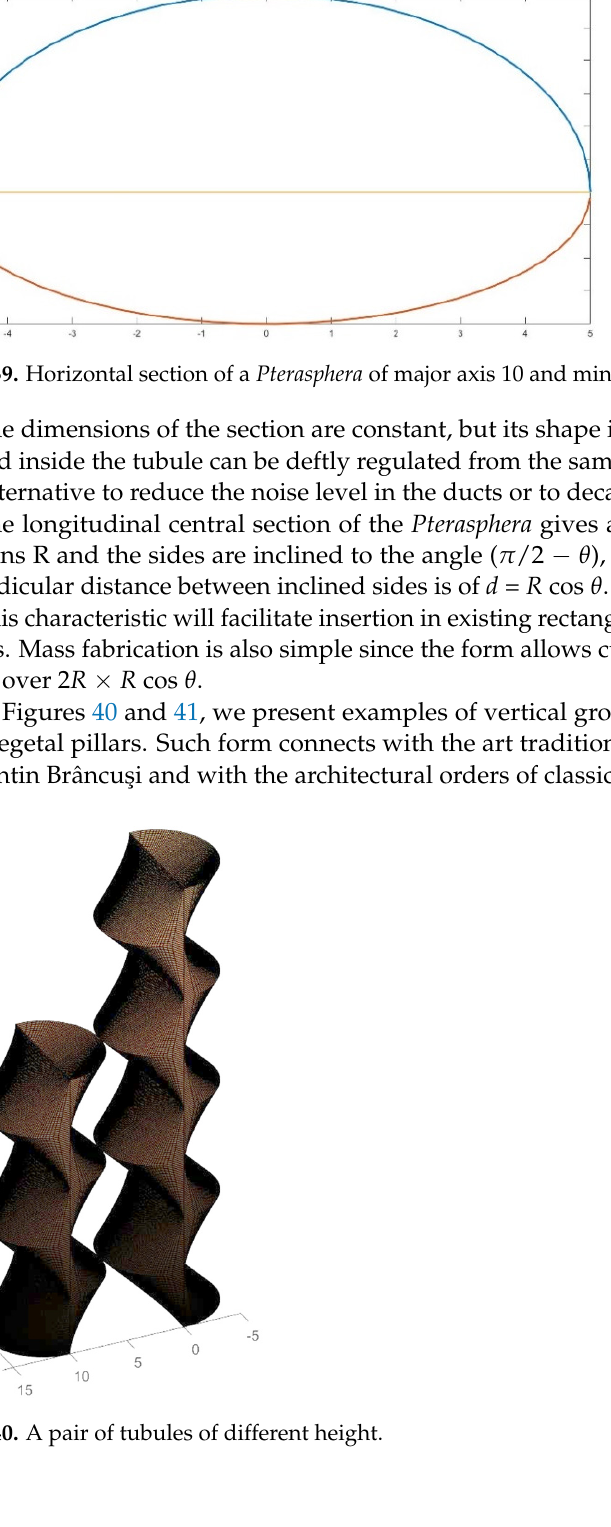
Figure 41. Different perspectives of the tubule. We decided to explicate this finding because of the possibilities that it showcases, for instance, in tower buildings. Vertical connections are always feasible at the middle plane of the column, but the external envelop will benefit from the sun ‐ tracking or shading properties already elucidated, combined with new photic materials of variable transpar ‐ ency (Figure 41). In consequence, lighting, thermal and acoustic features will considerably improve the existing conditions. The structure of the so ‐ conceived tower can be as lightweight as desired due to its inner balance and counterweight. As we have explained previously, alone or better in groups (Figure 42), it should perform adequately under earthquakes, extreme wind con ‐ ditions or other unpredictable circumstances.